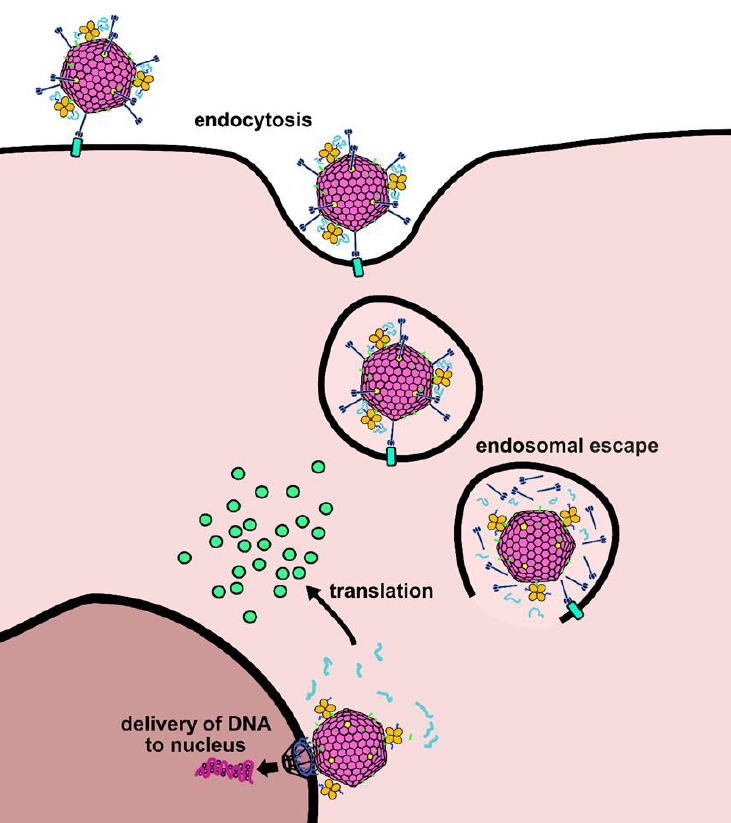
Figure 6. Proposed mechanism for mRNA delivery via AdpL nanosystem. In our proposed model, mRNA delivery is mediated by adenovirus cell entry biology. The AdpL-mRNA conjugate first binds to the target cell via interactions with the fiber protein and is taken up into endosomes. Previously described adenovirus biology results in escape of the conjugate from endosomes, at which point the mRNA may be released from the polylysine and translated into protein in the cytosol. The AdPK4 entry pathway may be different from the well-described HAdV5 pathway, but we hypothesize it will follow a similar